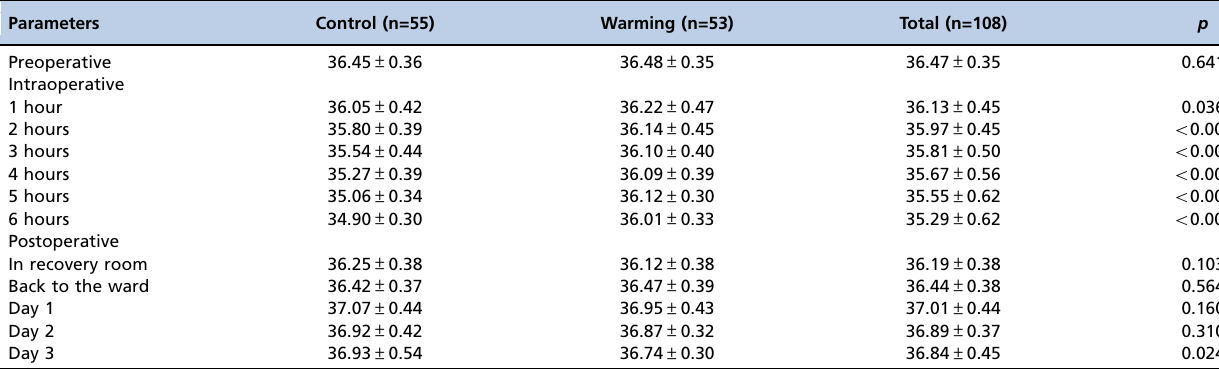
Table 3 - Change in the patient ’ s body temperature during the perioperative